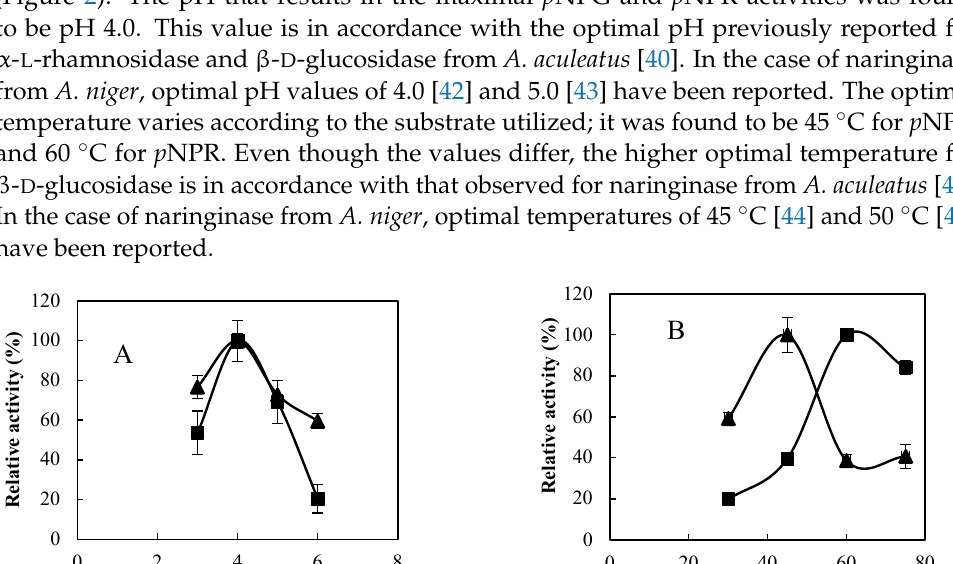
Figure 6. Kinetics of grapefruit juice debittering catalyzed by free enzyme: ⯁ Limonin; ● Naringin; ∎ Prunin; ⯅ Naringenin . ⯅ p -nitrophenyl- α - L -rhamnopyranoside ⯁ Before applying immobilized biocatalysts, the adsorption capacity of the supports was evaluated (Figure 7). Both enzyme ‐ free supports allowed for the adsorption of all bitter compounds; however, the best performance was observed with BGA, which